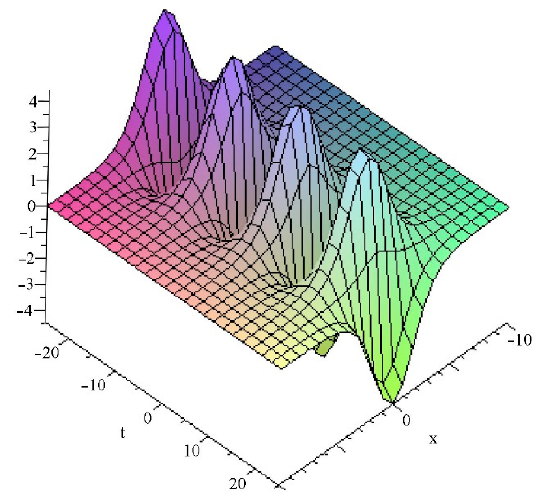
Figure 14. Geoblock displacement in the breather at V = 0.5.